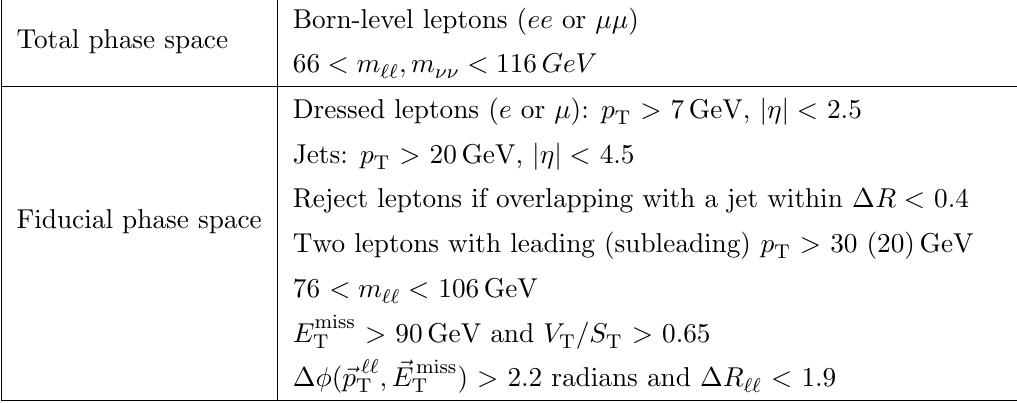
‘‘(cid:23)(cid:23) signal. !